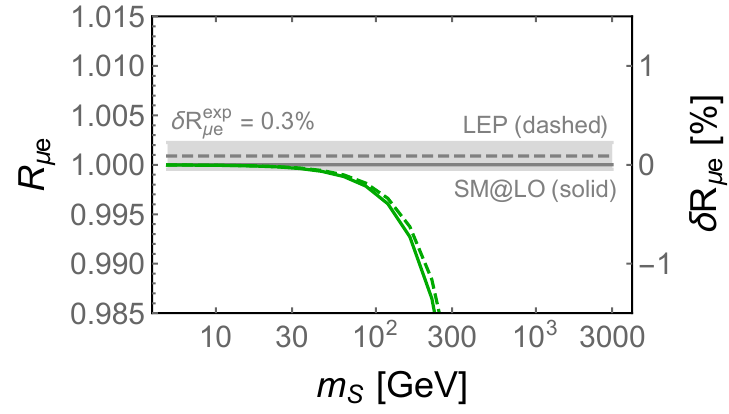
Figure 10 . SM expectation for the ratio R µe and its minimum deviation due to muon mixing if a singlet scalar model UV completed by fermion mediators resolves the ( g − 2) µ anomaly. The gray solid line represents the leading order-calculation, and the gray dashed line with shaded band shows the experimental result from LEP with an error of 0 . 3% [120]. The solid (dashed) green line represents the fermion UV completion L ( L ) from eq. I II